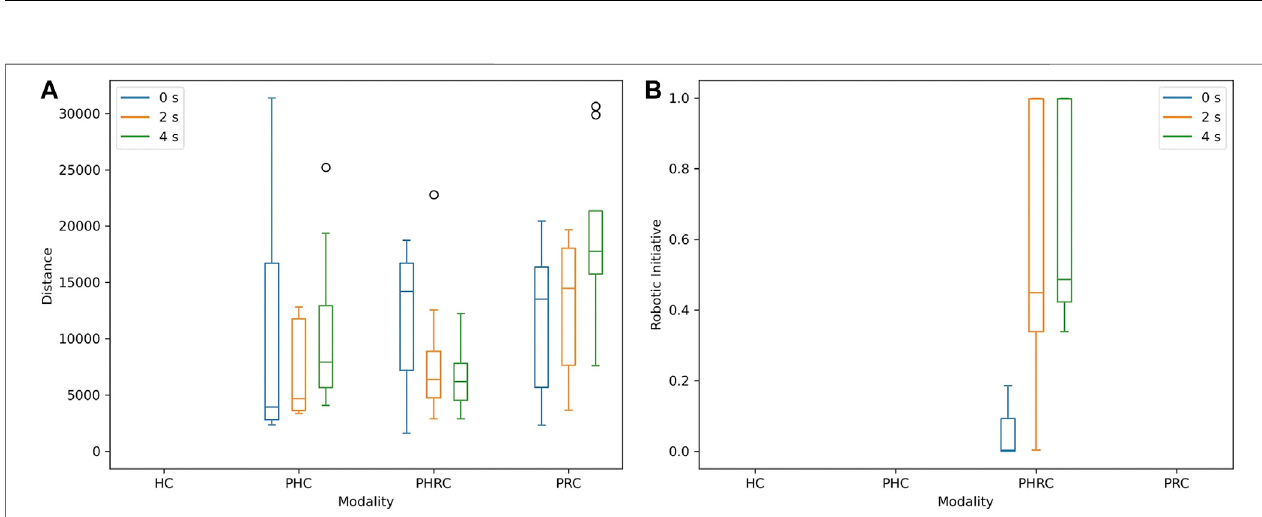
FIGURE 10 | Box plots of average distance between predicted output ^ Tx t and real output Tx t (A) , and average robotic initiative ri (B) . Average ri is computed by using Eq. 8 and taking the mean value for 0 ≤ t ≤ t end .